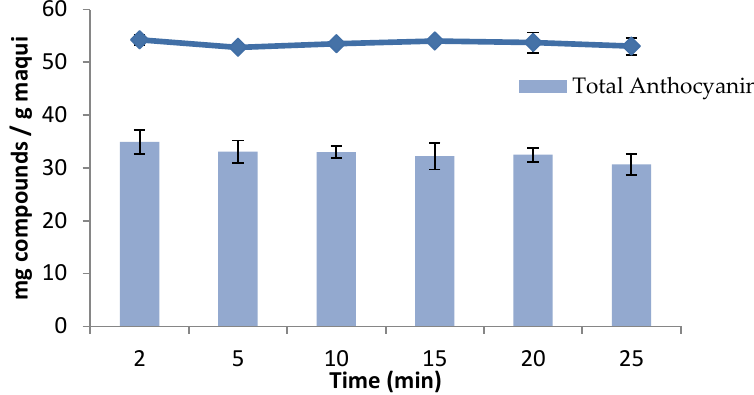
Figure 4. Recovery of total phenolic compounds (mg g − 1 ) and total anthocyanins (mg g − 1 ) using different extraction times ( n = 3).